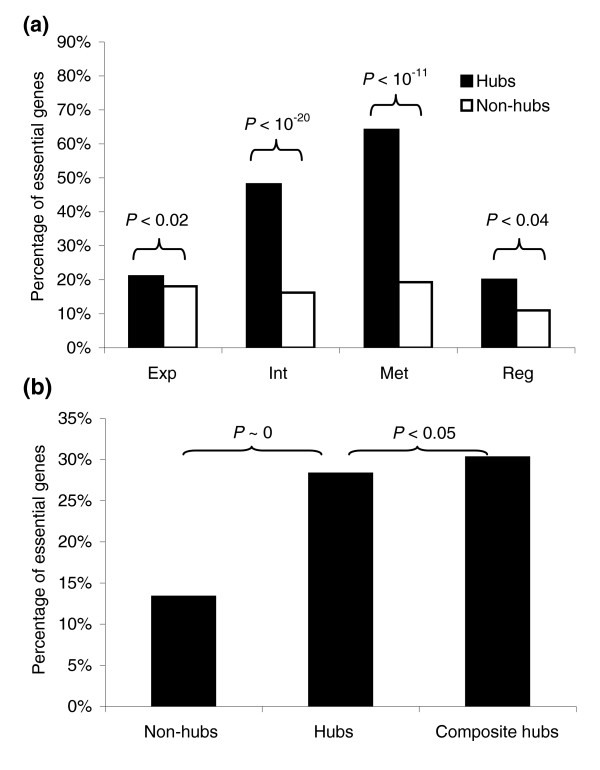
Analysis of the essentiality of hubs and composite hubs. (a) Comparison of the percentages of essential genes in hubs and non-hubs in different networks. P values measure the significance of differences between the percentages for hubs and non-hubs. (b) Comparison of the percentages of essential genes in non-hubs, hubs and composite hubs. In this figure, we excluded all composite hubs when calculating the percentage for hubs. Due to the limited number of tri-hubs, we combined them with bi-hubs. P values measure the significance of the differences between neighboring bars. Met, the metabolic network; Int, the interaction network; Exp, the co-expression network; and Reg, the regulatory network (in Figures 2 and 3, we only consider the regulator population in the regulatory network).